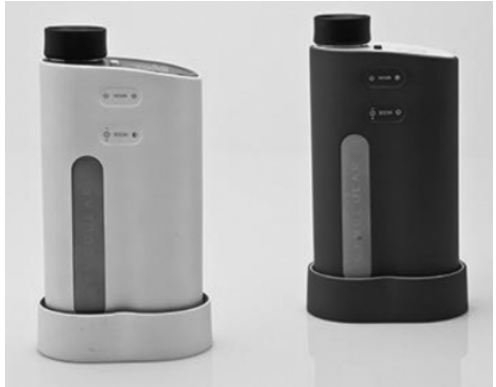
Figure 6. The portable colposcope, Gynocular, from Gynius Plus AB (Reprinted from [62]).